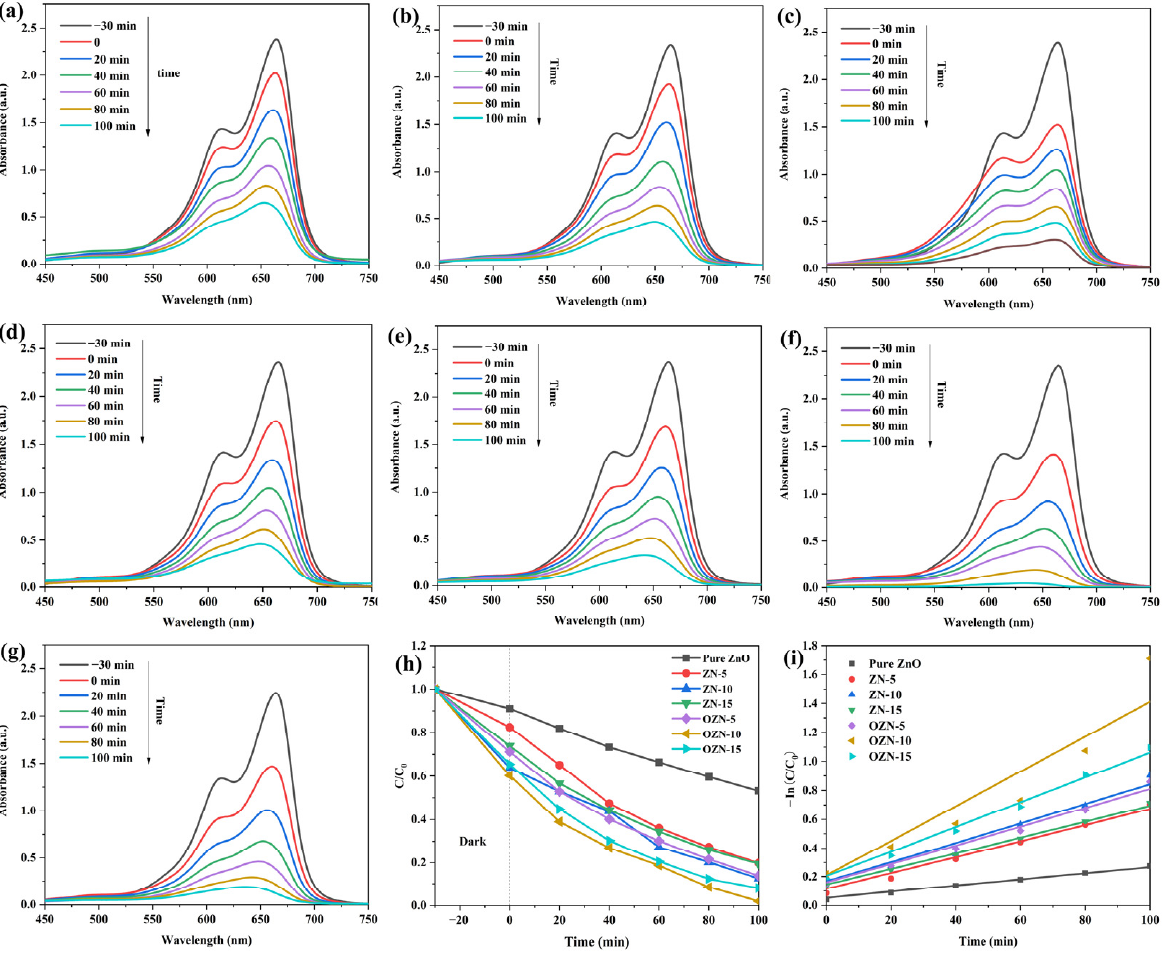
Figure 9. In the presence of 10 mg ( a ) ZnO, ( b ) ZN-5, ( c ) ZN-10, ( d ) ZN-15, ( e ) OZN-5, ( f ) OZN-10, and ( g ) OZN-15, the absorption spectra of 30 mg/L methylene blue solution under visible light irradiation. ( h ) Degradation efficiency of pure ZnO, ZN and OZN samples. ( i ) First-order kinetics of degradation of pure ZnO, ZN and OZN samples.